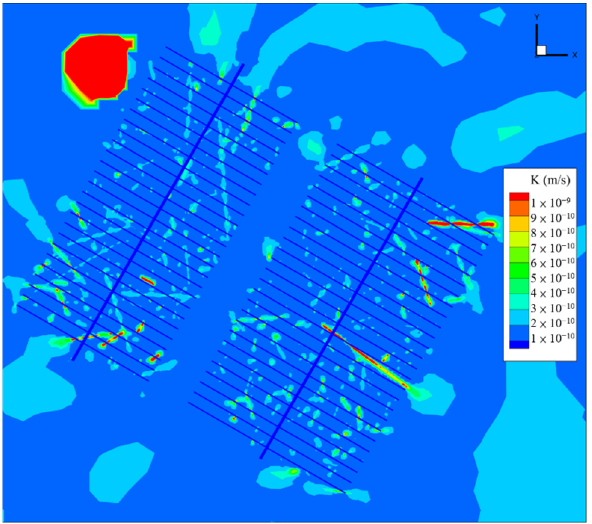
Figure 8. The plan view of the effective hydraulic conductivity based on the example DFN in the repository area. repository